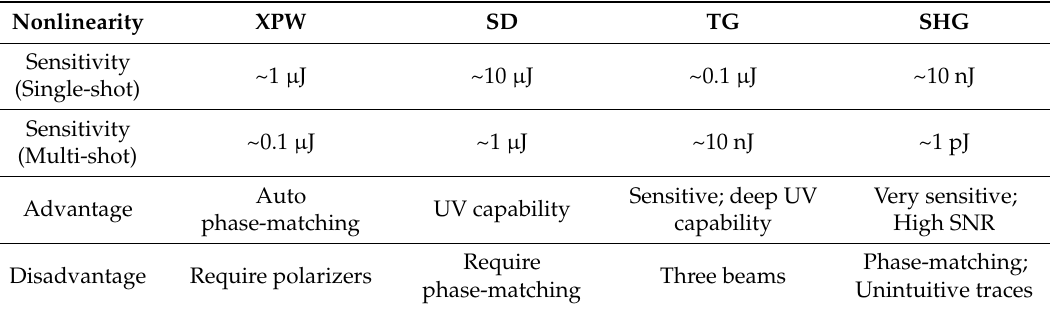
Table 1. Comparison of di ff erent nonlinearities applied for FROG